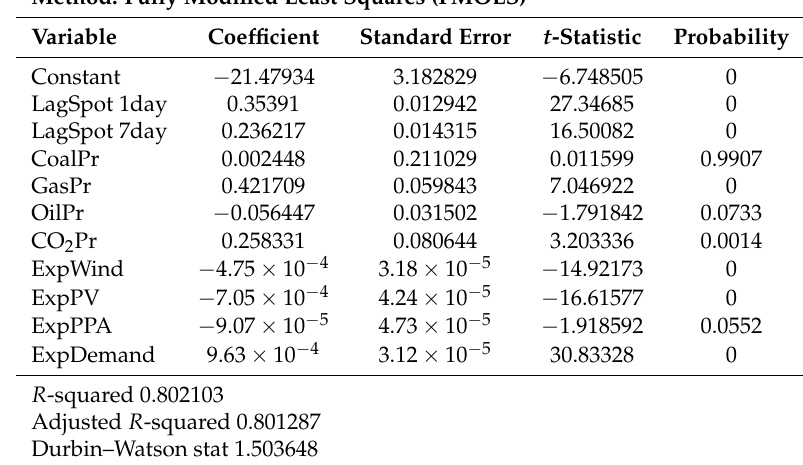
Table 6. Estimation results of Equation (2): Marginal effects of fundamental variables on